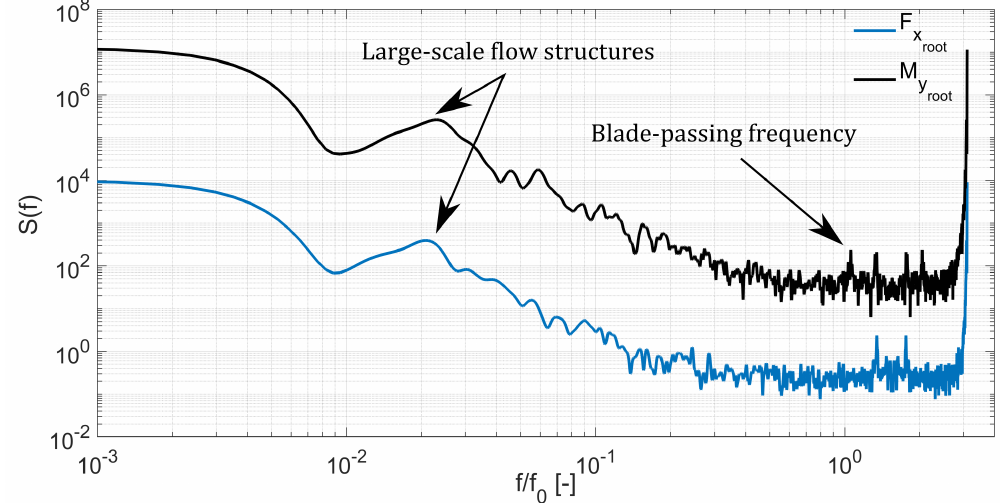
Figure 14. Power Spectral Density of F x and M y computed over a 5-min interval during ebb tide root root at a maximum rotational speed of Ω = 11.61 RPM. The spectra were obtained from an individual blade, with the spectral energy of F x multiplied by 10 2 to facilitate root